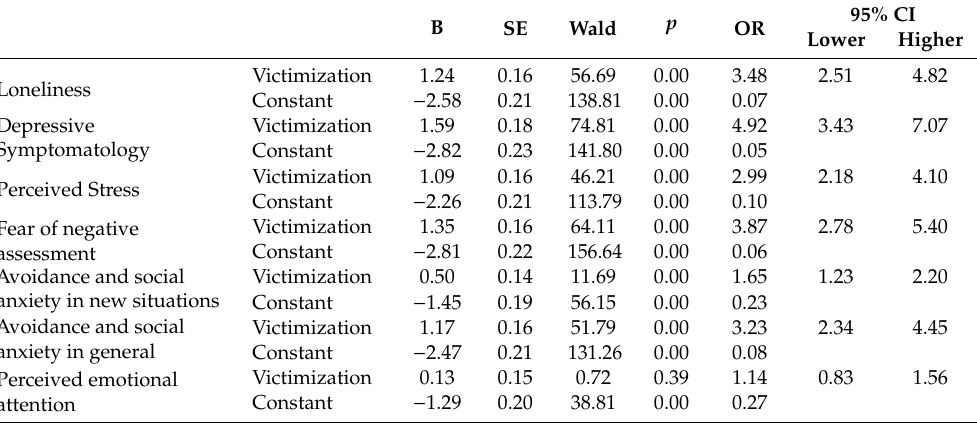
Table 8. Logistic regression with cybervictimization as a predictor of high